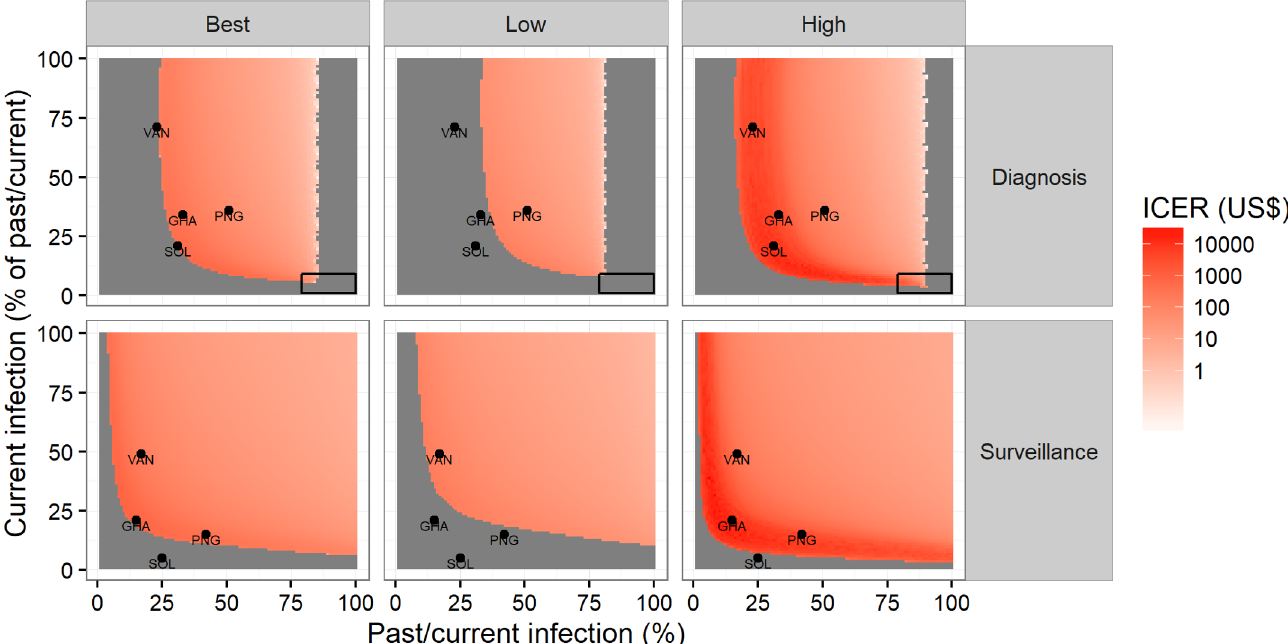
Fig 5. Incremental cost-effectiveness (cost per correct diagnosis gained) of the combined testing strategy across different scenarios of prevalence, by use case. Best—best estimate (median); Low—lowestimate (2.5th centile); High—highestimate (97.5th centile); ICER—Incremental Cost EffectivenessRatio (cost per correct diagnosis);black rectanglesindicate where the sequential strategy may be more costly and more effective; grey areas without an ICER value indicate negativeICERs, where the combinedtesting strategy is less effective and more costly or more effective and less